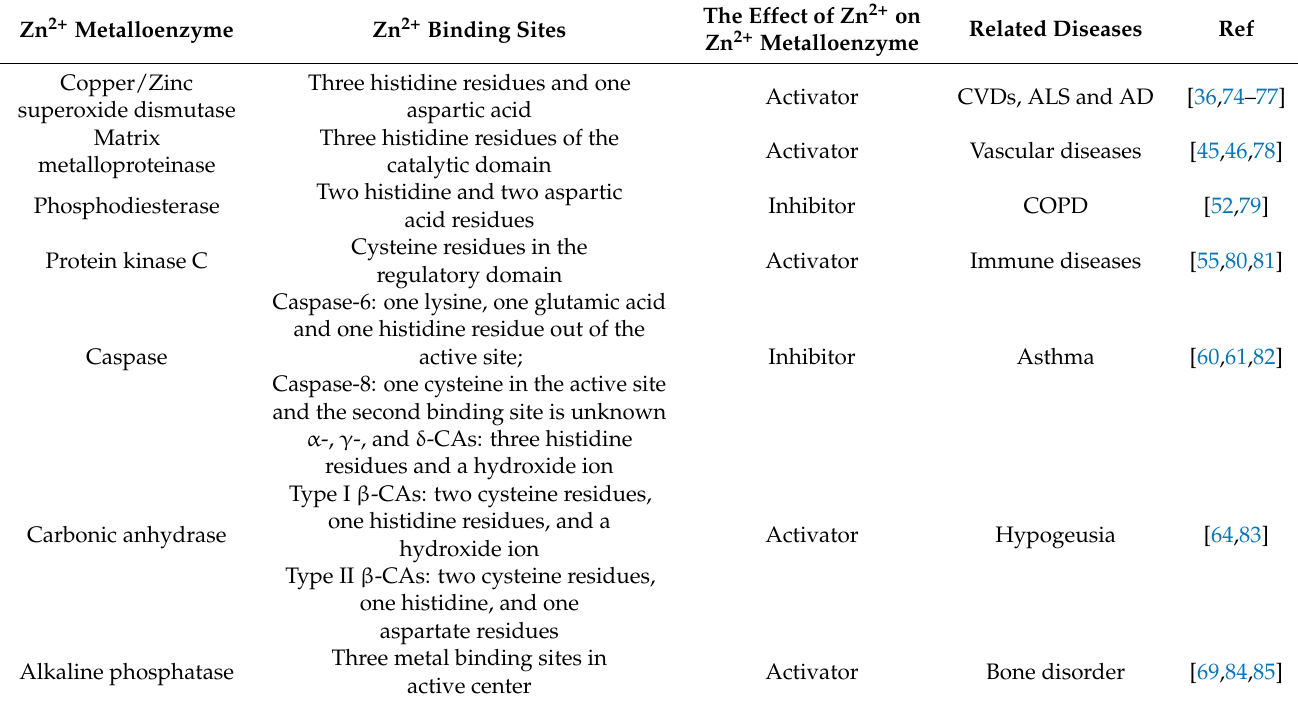
Table 1. The list of Zn 2+ metalloenzymes and related human